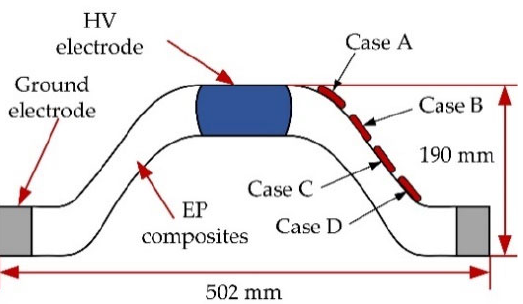
Figure 1. Illustration of EP sample with electrodes and surface particle. Particle corresponding to Cases A to D distributes quarterly along the insulator surface.